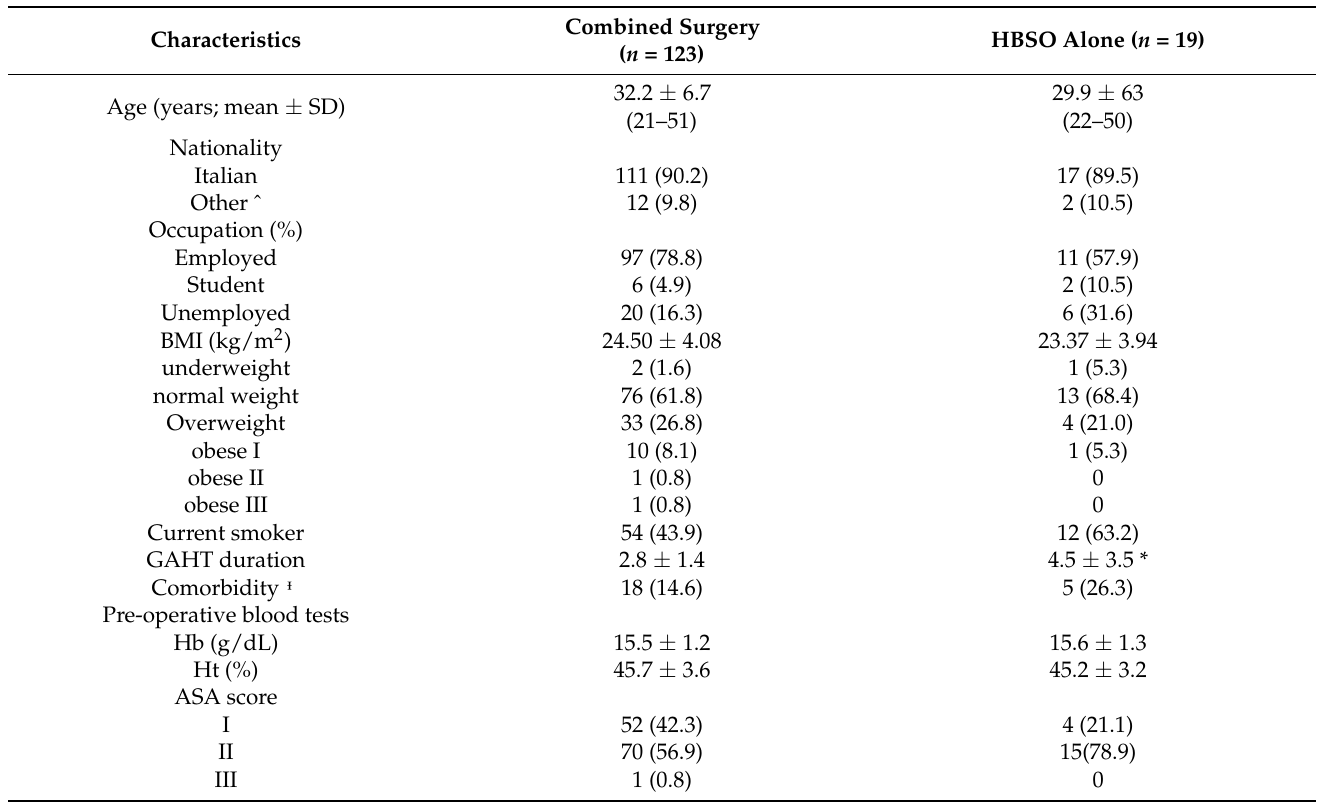
Table 1. Demographic and basal characteristics of subjects undergoing combined surgery and hysterectomy with bilateral salpingo-oophorectomy (HBSO) alone.